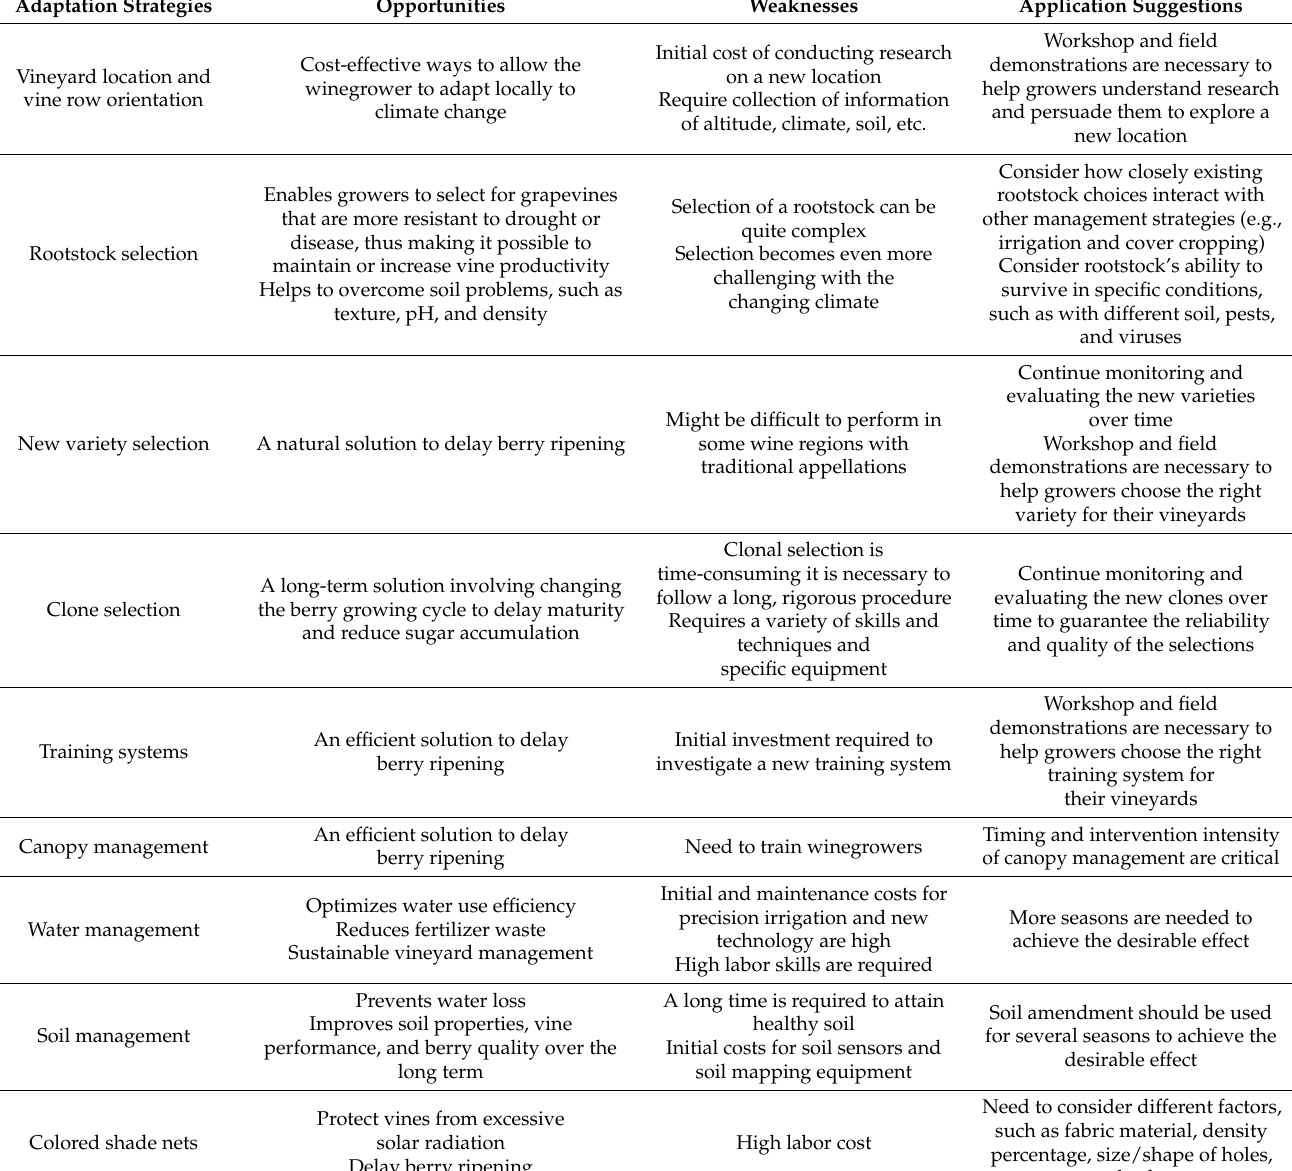
Table 3. Summary of the strategies for climate change